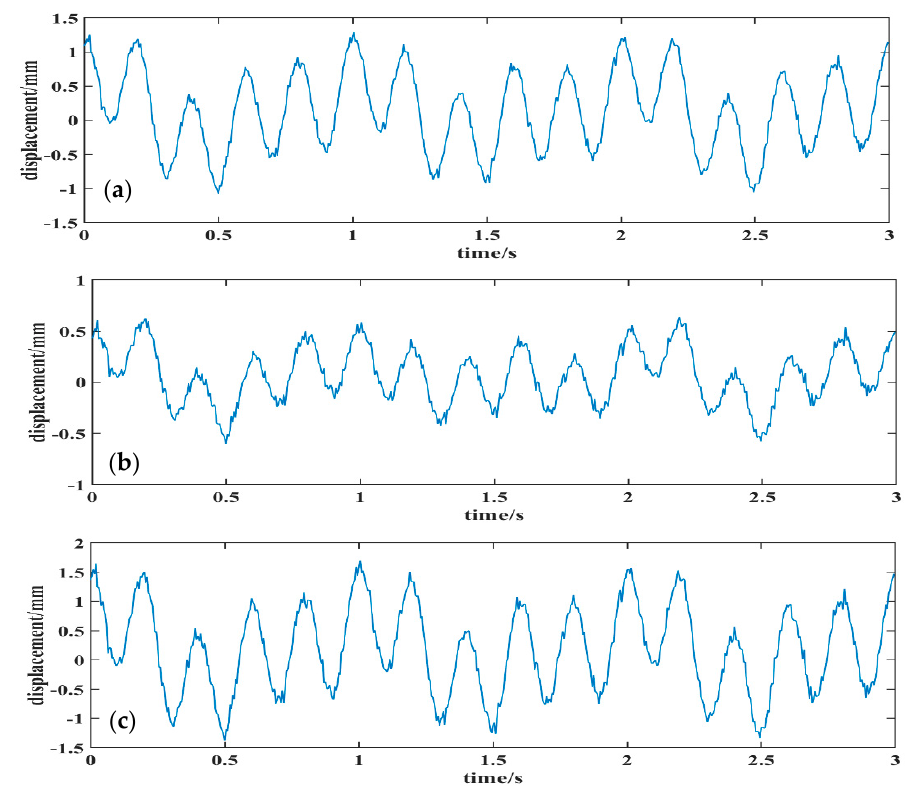
Figure 3. Three sets of simulation source signals. ( a ) The curve of signal